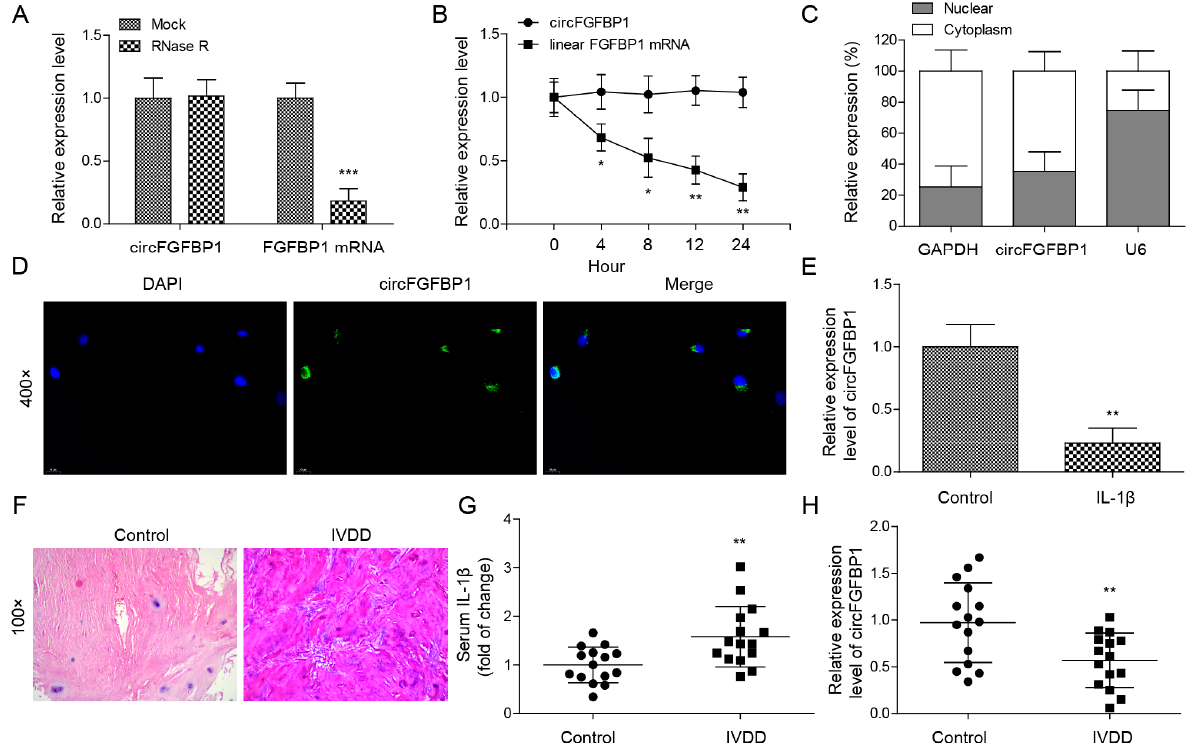
Figure 1. Ectopic expression of circFGFBP1 in NP cells and tissues of IVDD. ( A ) Expressions of circFGFBP1 and FGFBP1 mRNA by qPCR. ( B ) RNA stability assay by actinomycin D. ( C , D ) Subcel- lular distribution of circFGFBP1 by qPCR ( C ) and FISH ( D ). ( E ) CircFGFBP1 expression in NP cells stimulated by IL-1 β . n = 3. ( F ) Histopathological changes in degenerative intervertebral disc by H&E staining. ( G ) Serum IL-1 β by ELISA. ( H ) CircFGFBP1 expression in NP tissues from IVDD patients. n = 15. Data were estimated as mean ± SD. * p < 0.05, ** p < 0.01, *** p < 0.001.